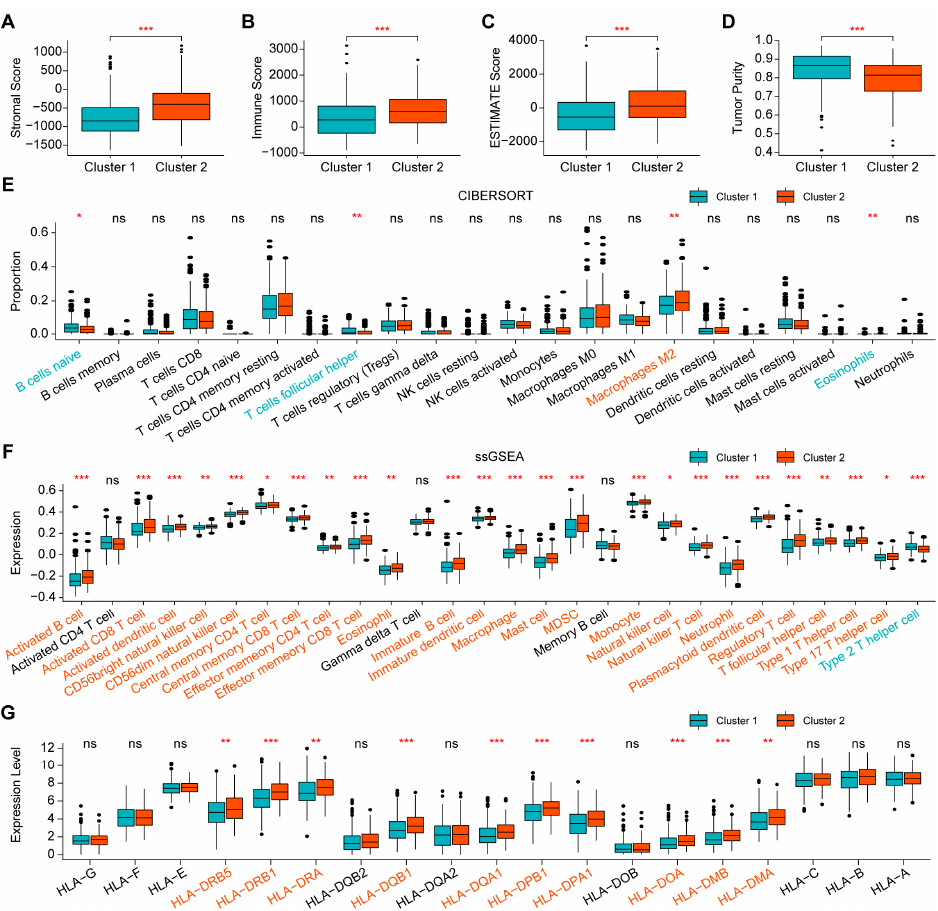
Figure 2. Comparison of immune infiltration between the two clusters. ( A – D ) Comparison of the four ESTIMATE indices, including stromal score, immune score, ESTIMATE score and tumor purity. ( E ) Comparison of the proportion of immune cells by CIBERSORT. ( F ) Comparison of the expression of immune cells by ssGSEA. ( G ) Comparison of the expression of MHCs. NS: no significance, * p < 0.05, ** p < 0.01, *** p < 0.001.